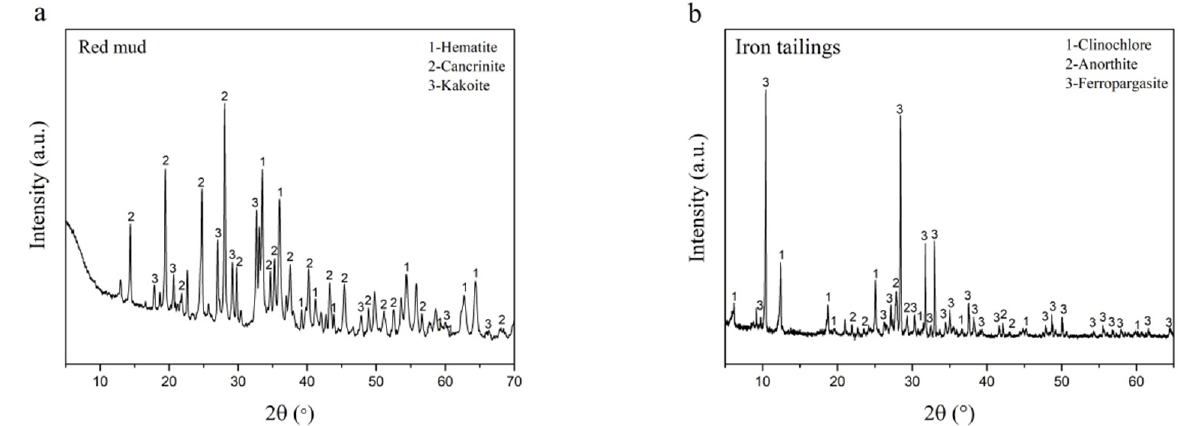
Figure 1. XRD patterns of Bayer red mud ( a ) and iron tailings ( b ). Table 1. Chemical composition and origin information of raw materials.